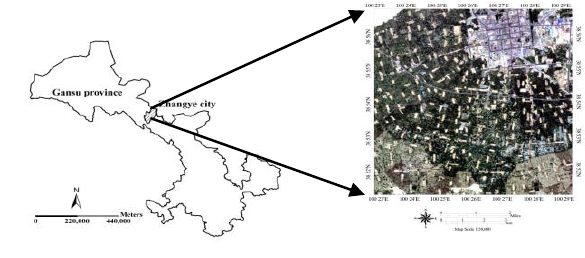
Figure 1. the study area of CHRIS (band 7, 4,